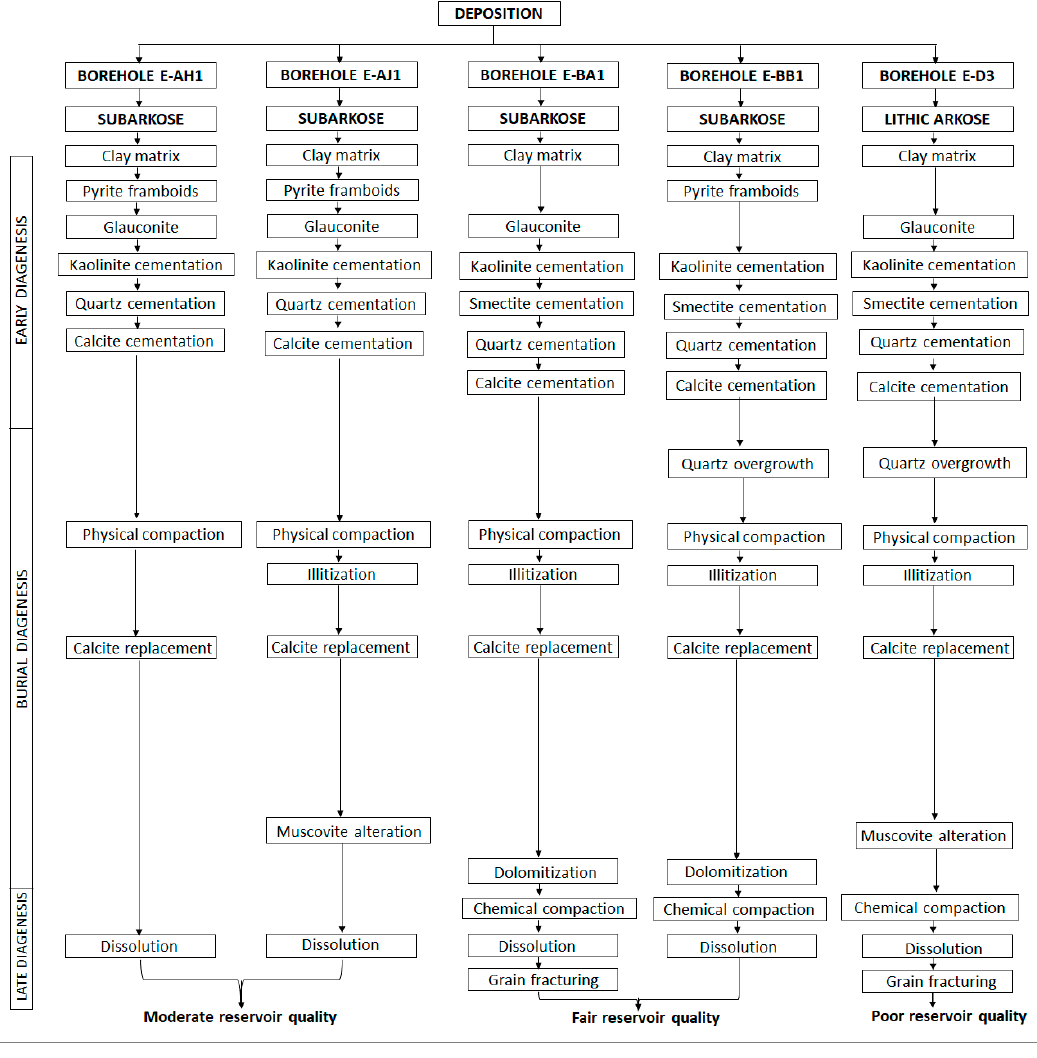
Figure 11. Flow chart of the main diagenetic processes in Bredasdorp sandstones and their inferred potential reservoir quality.